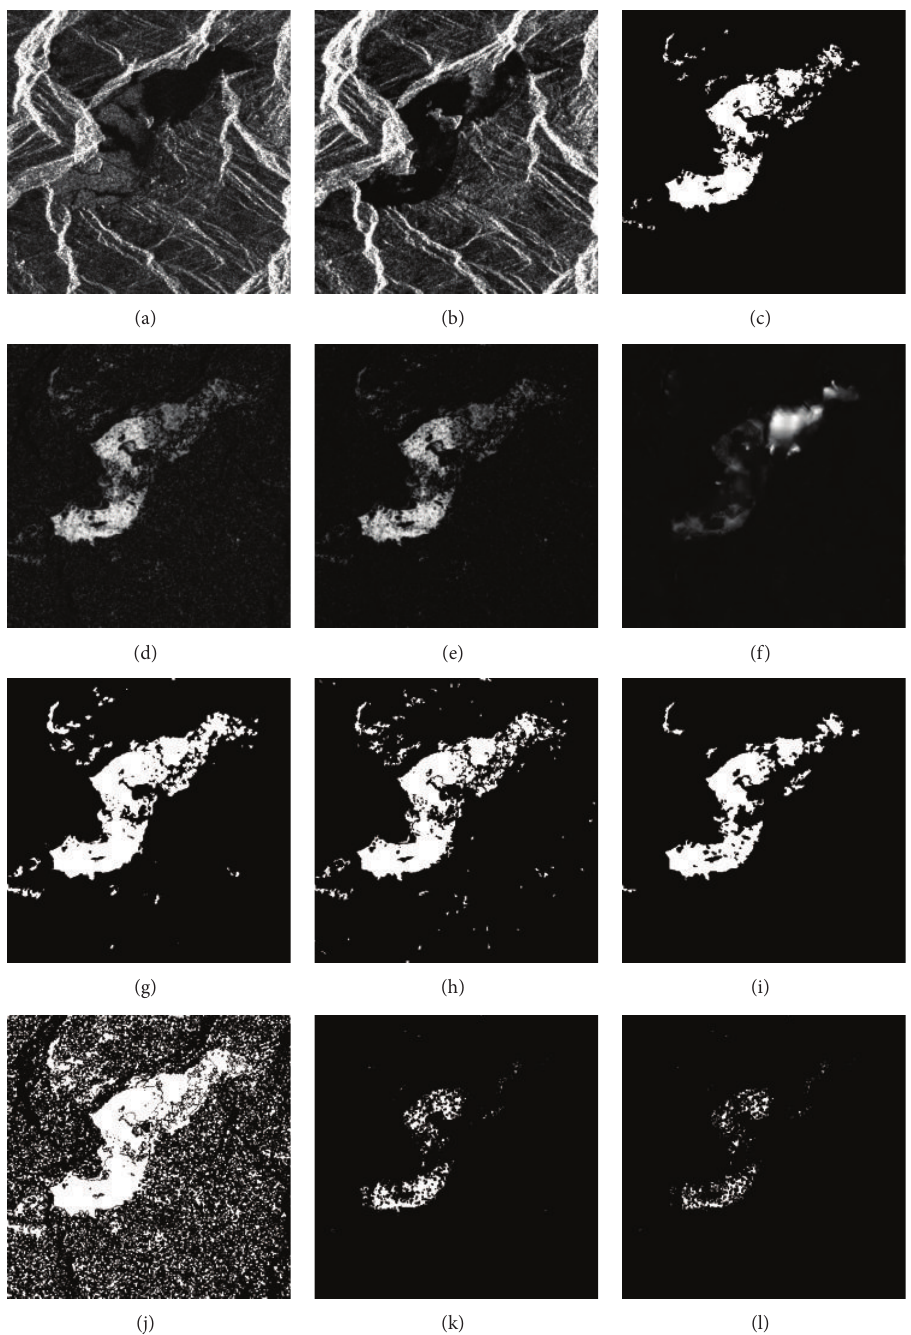
Figure 4: Experimental results on WenChuan Water dataset. (a) Image acquired in March 2008, (b) image acquired in June 2008, (c) ground truth, (d) LR DI, (e) NLR DI, (f) CKLD DI, (g) change map by CWT-EM, (h) change map by MRF-FCM, (i) change map by MSRM, (j) change map by LR-GKIT, (k) change map by NLR-GKIT, and (l) change map by GR-HRT.